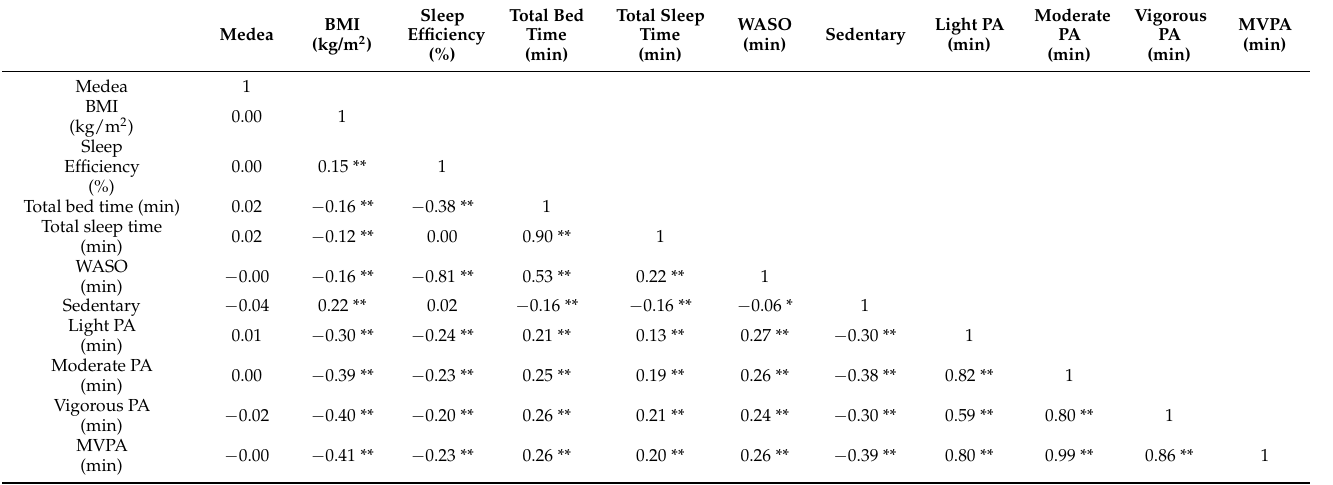
Table 9. Correlation of the daily sleep quality and PA